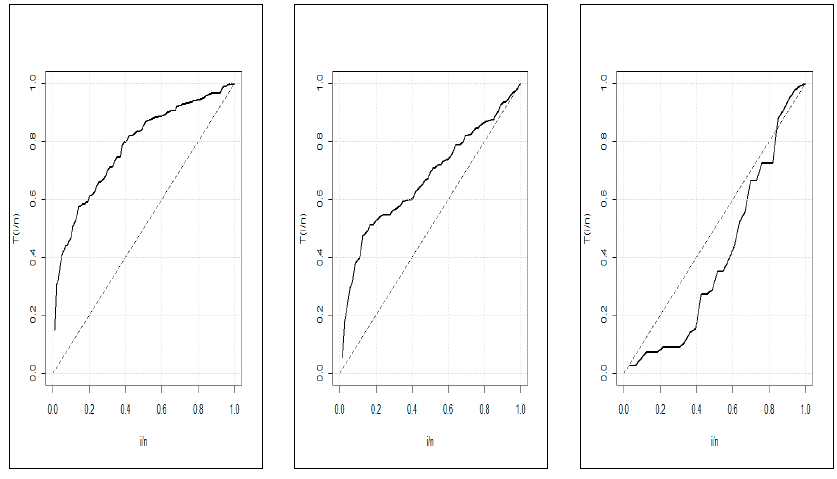
Figure 2. Total time test (TTT) plots.